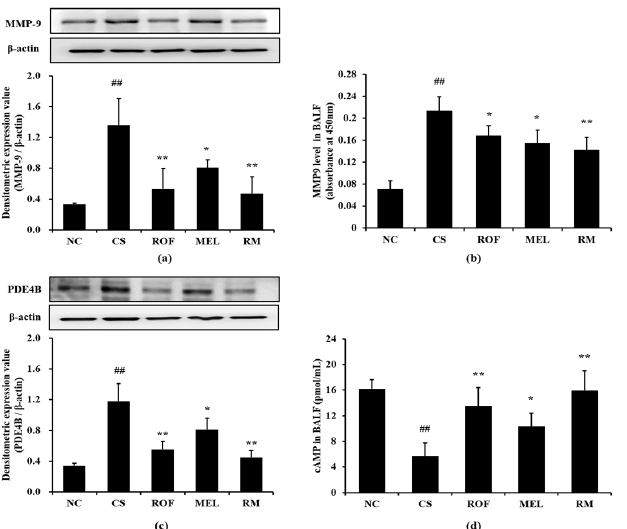
Figure 4. Melatonin reduced the elevation of MMP-9, PDE4B and cAMP in CS-exposed mice. ( a ) MMP-9 expression, ( b ) MMP-9 level in BALF, ( c ) PDE4B expression, ( d ) cAMP level in BALF. NC: non-treated and non-exposure group; CS: PBS-treated and CS+LPS exposure group; ROF: roflumilast-treated and CS+LPS exposure group, MEL: melatonin-treated and CS+LPS exposure group, RM: roflumilast and melatonin co-treated and CS+LPS exposure group. The data are expressed as mean ± SD (n = 5). ## Significantly different from the NC group, P < 0.01; *, ** significantly different from the CS group, P < 0.05 and < 0.01, respectively.